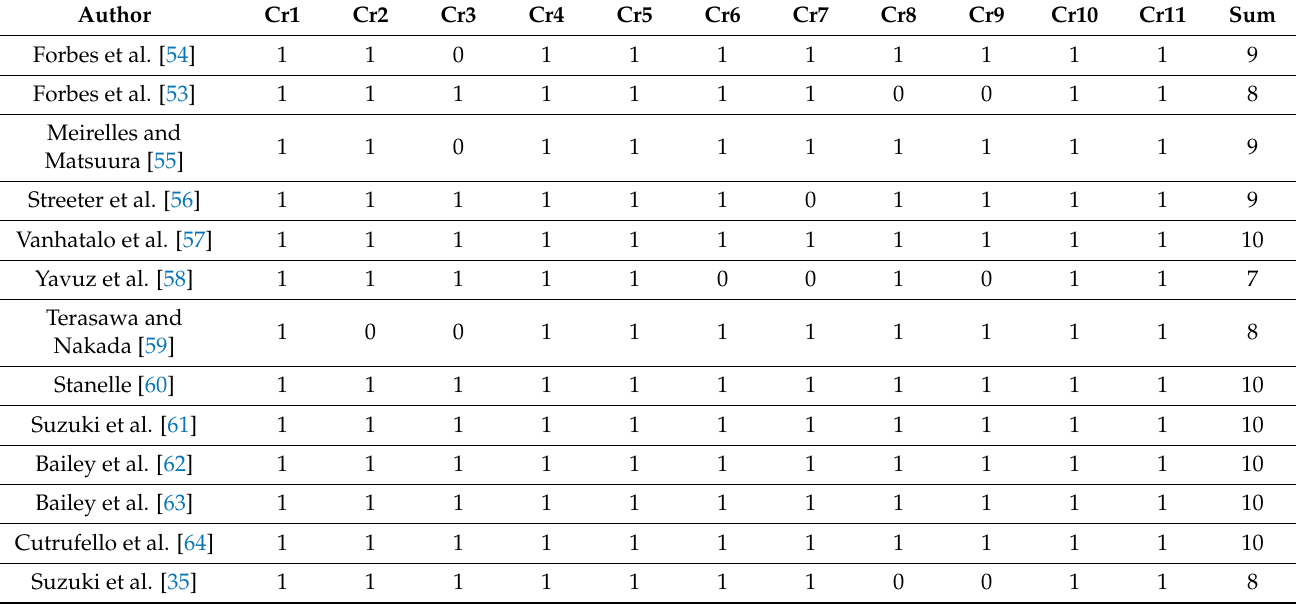
Table 2. Results of risk of bias